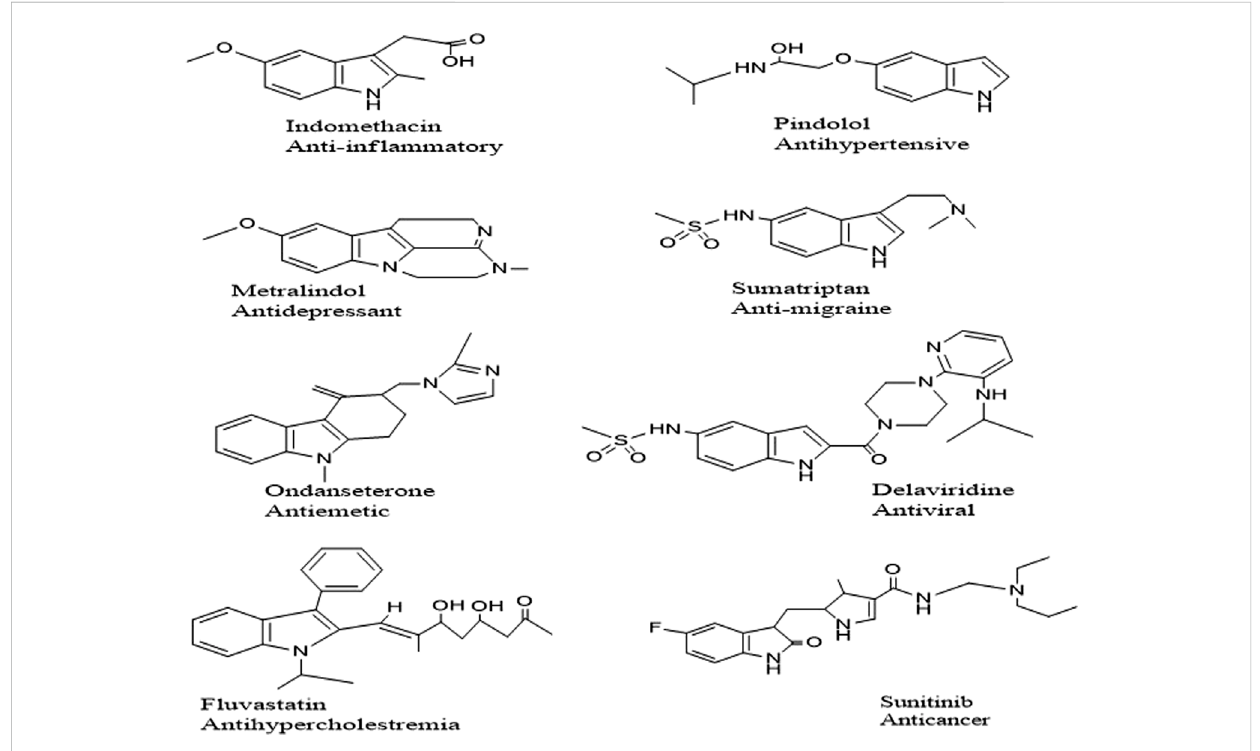
FIGURE 1 Selected Examples of FDA approved Indole based